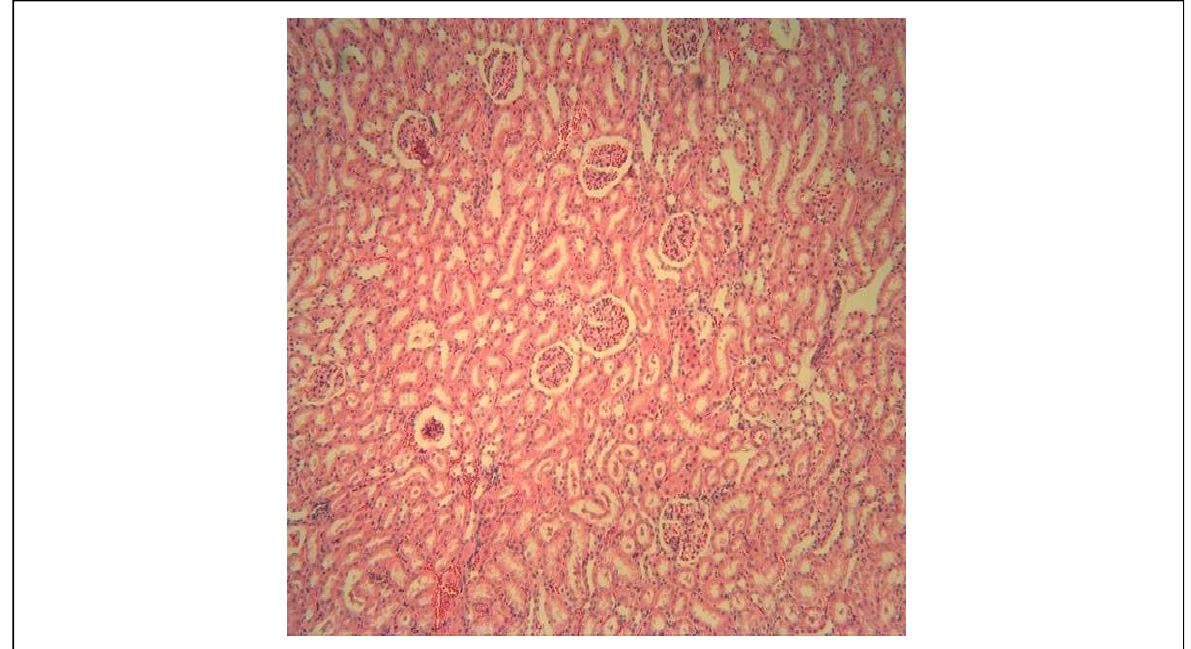
Plate 9: Effect of methanol extract of N. laevis on the kidney of group C rats administered leaf extract of N. laevis 600 mg/kg + 8,000 mg/kg